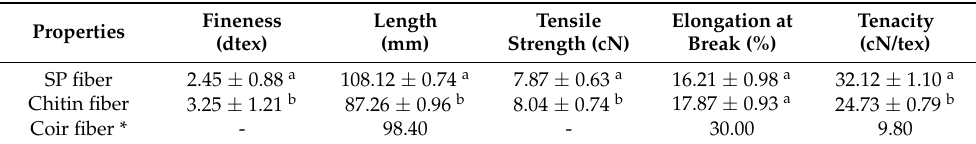
Table 6. Mechanical properties of soy protein (SP), chitin, and coir